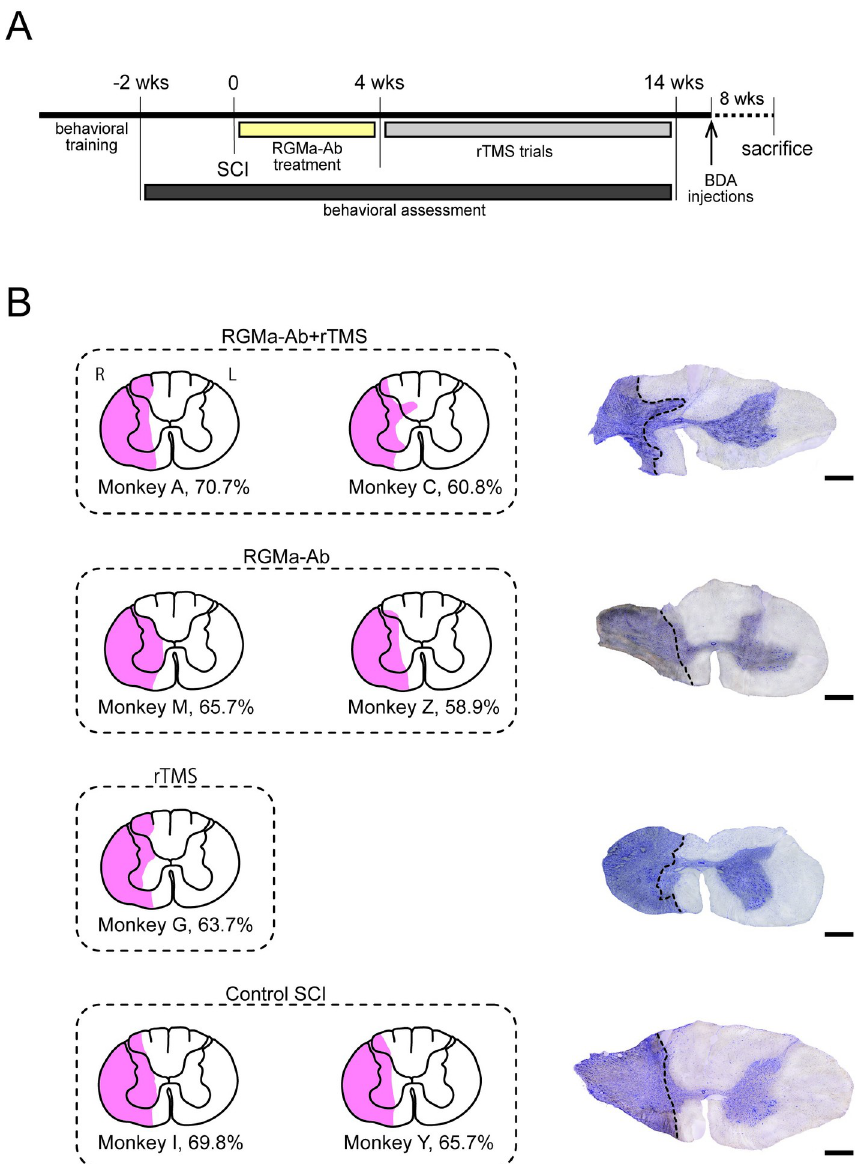
Fig 1. Experimental design and extent of SCI lesions. (A) Experimental design. According to a modified Brinkman board test, dexterous motor behavior was assessed over a total of 16 weeks (wks) before and after SCI (2 and 14 weeks, respectively). Treatment with anti-RGMa antibody (RGMa-Ab) was started concurrently with the SCI surgery and continued for four weeks. Following the antibody treatment, rTMS trials over the forelimb region of the MI were performed for a total of approximately 10 weeks. Then, BDA injections into the contralesional MI were made about eight weeks before sacrifice. (B) Extent of SCI lesions (in pink) overlaid on a template transverse section. Lesions were made unilaterally at the border between the C6 and the C7 level to involve largely the lateral sector of the cervical cord. Monkeys A and C with both the antibody treatment and rTMS (RGMa-Ab+rTMS), monkeys M and Z with the antibody treatment alone (RGMa-Ab), monkey G with rTMS alone (rTMS), and monkeys I and Y without either the antibody treatment or rTMS (Control SCI). Each percentage represents the ratio of the lesioned area to the total area of a hemi-transverse section. Note that there is no marked difference in the extent of SCI lesions (58.9–70.7%) across the seven monkeys. L, left; R, right. On the right side, photomicrographs of representative sections Nissl-stained with Cresyl violet taken from monkeys C, Z, G, and Y. Scale bars, 1